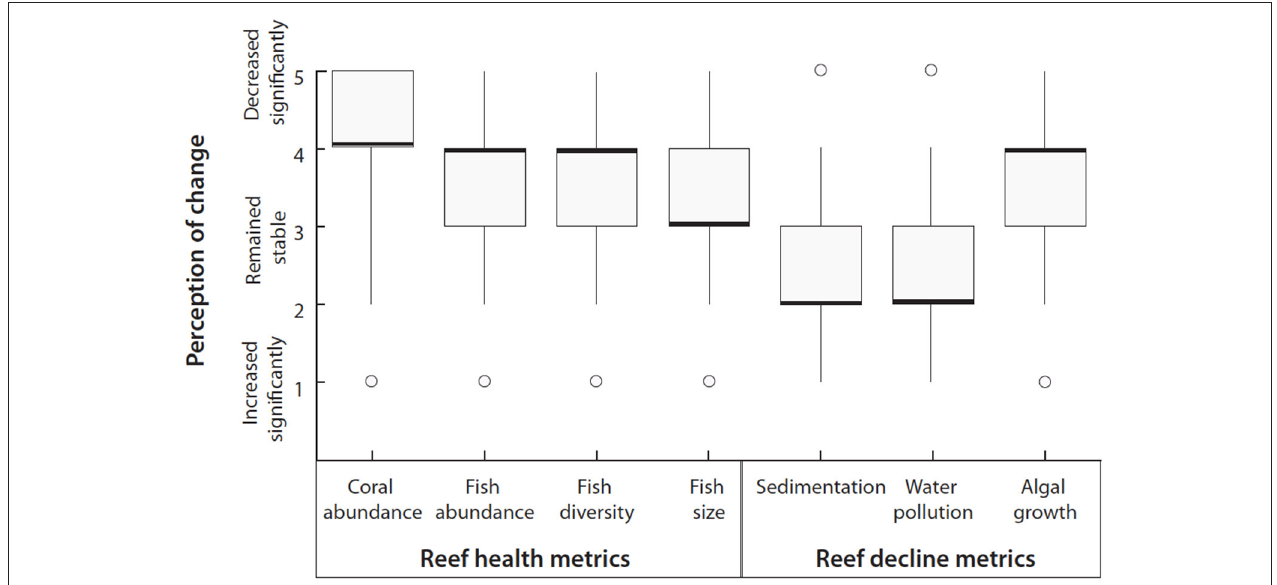
FIGURE 2 | Perceived changes in coral reef ecosystems. Median, quartile, and extreme values for each of the seven metrics of reef health (coral abundance, reef fish abundance, reef fish diversity, reef fish size) and reef degradation (water pollution, sedimentation, and algal growth).